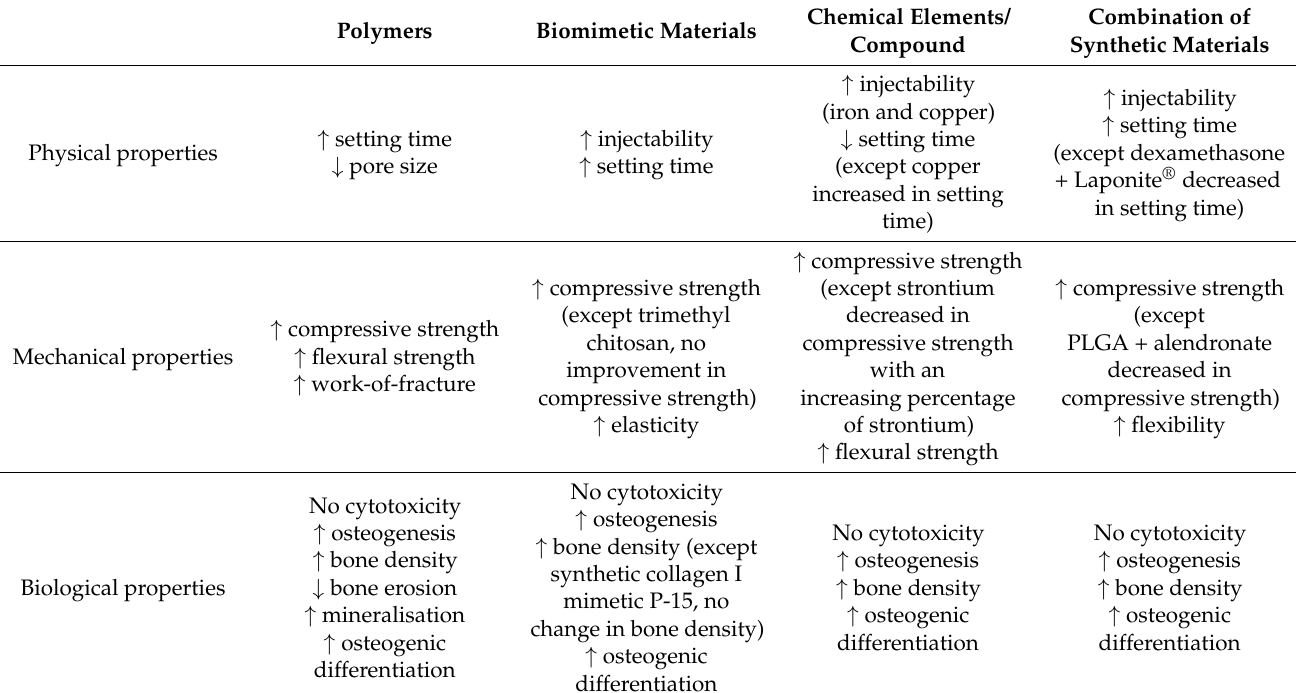
Table 5. The characteristics of CPC upon enhancement by different types of synthetic